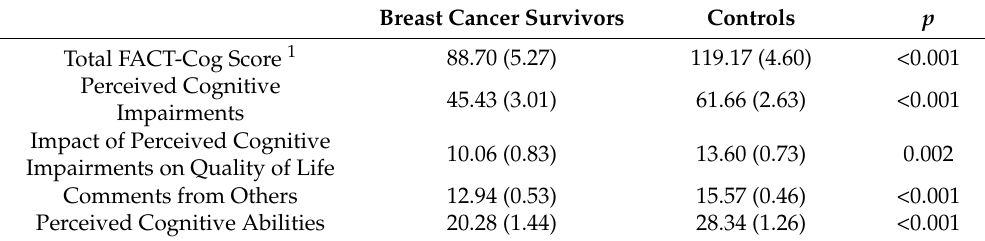
Table 3. Self-Reported Cognitive